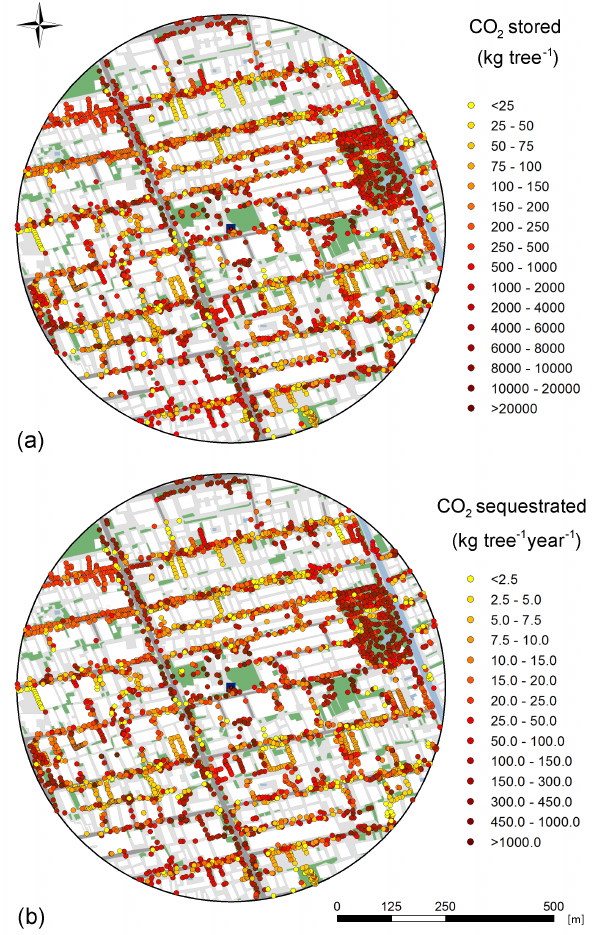
Fig. 5. (a) CO 2 stock and (b) sequestration rates for all inventoried trees (woody, palm trees and banana plants) within the sampling domain. Blue square in center of panel is location of EC tower. The similarity in spatial distribution of both parameters is expected given that they strongly depend on tree size. The important contri- bution to the carbon cycle by large trees located along main roads and in a small park towards the WNW is